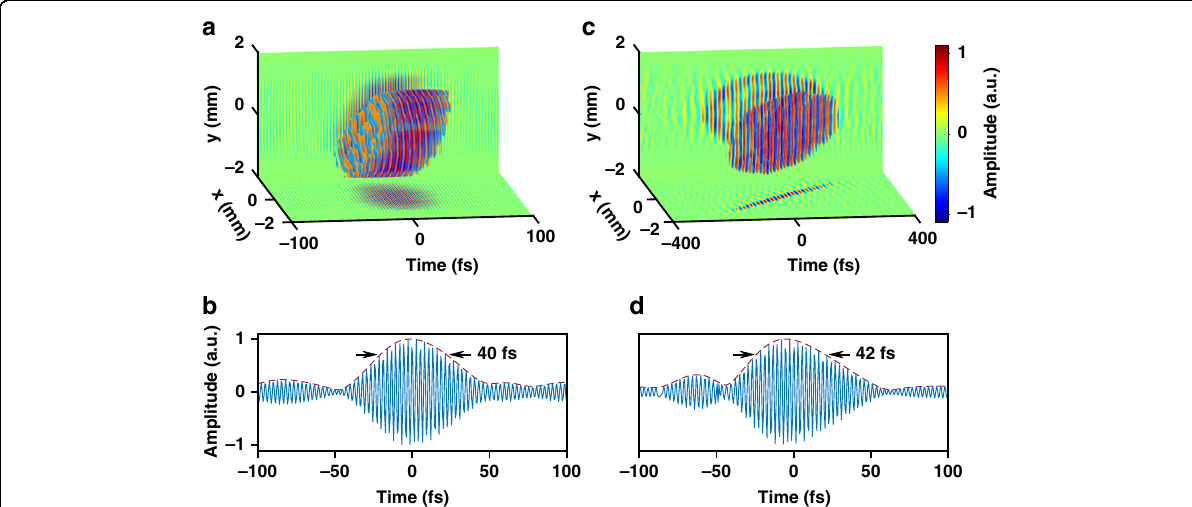
Fig. 2 3D topographic maps of femtosecond laser pulses measured by COFT based on wavefront retrieval and non-collinear FROG. a Spatiotemporal distribution of the electric fi eld of a femtosecond laser pulse from a kilohertz, millijoule femtosecond laser ampli fi er. b Temporal pro fi le of the electric fi eld (blue lines) at the central point x ; y ð Þ ¼ 0 ; 0 ð Þ of the laser pulse in a , and the red dashed line shows the amplitude envelope. c Similar to a , but for spatiotemporal electric fi eld distribution of a femtosecond laser pulse with spatiotemporal coupling, which is induced by propagating the laser pulse in a glass prism at CP. To avoid too fast oscillations of the fi eld and get a clear visualization, the carrier wave frequency in c has been numerically reduced by 10 times. d Similar to b , but for the temporal pro fi le of the electric fi eld at the central point in c . To clearly show the peaks and valleys of the optical fi elds in a and c , only regions where the absolute amplitude is higher than 0.4 times the peak absolute amplitude are